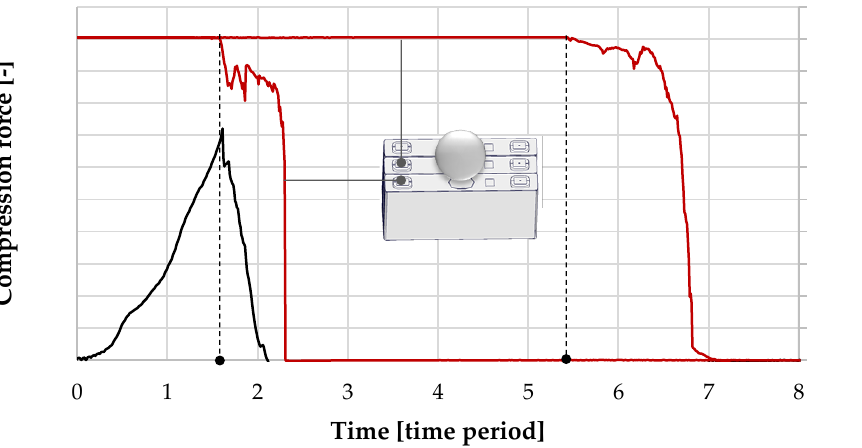
Figure 10. Compression force and state of charge over time for middle and right cells at test in w-direction with hemispherical